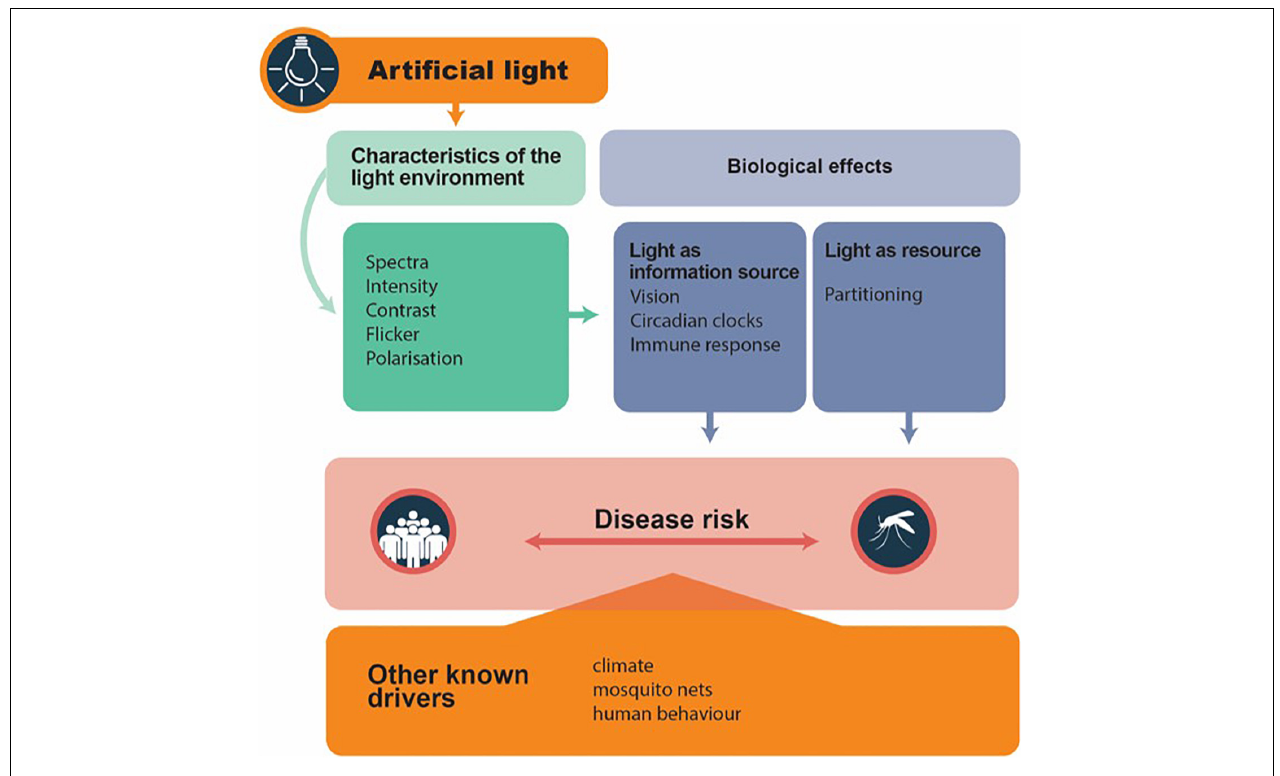
FIGURE 1 | Conceptual illustration to predict how artificial light may act as a modulator to mosquito-borne disease transmission. It captures the characteristics of the light environment which alter species biologically respond to light, which then may modulate disease transmission risk. Note that all the other known drivers can interact with that of artificial light to influence disease transmission risk. Simplified from Gaston et al.